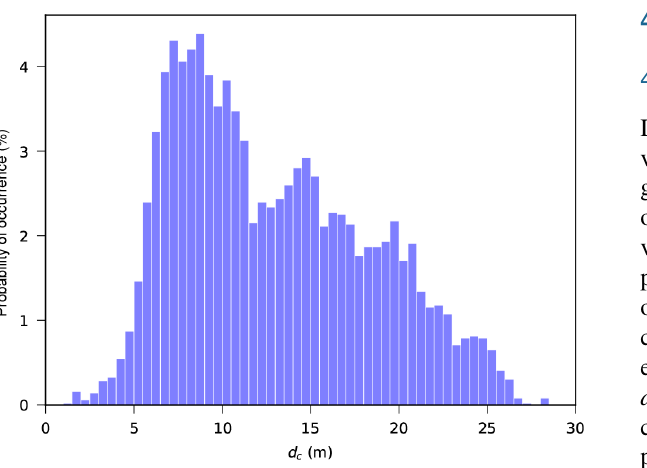
Figure 3. Histogram of the probability of occurrence of d c globally (using bins of